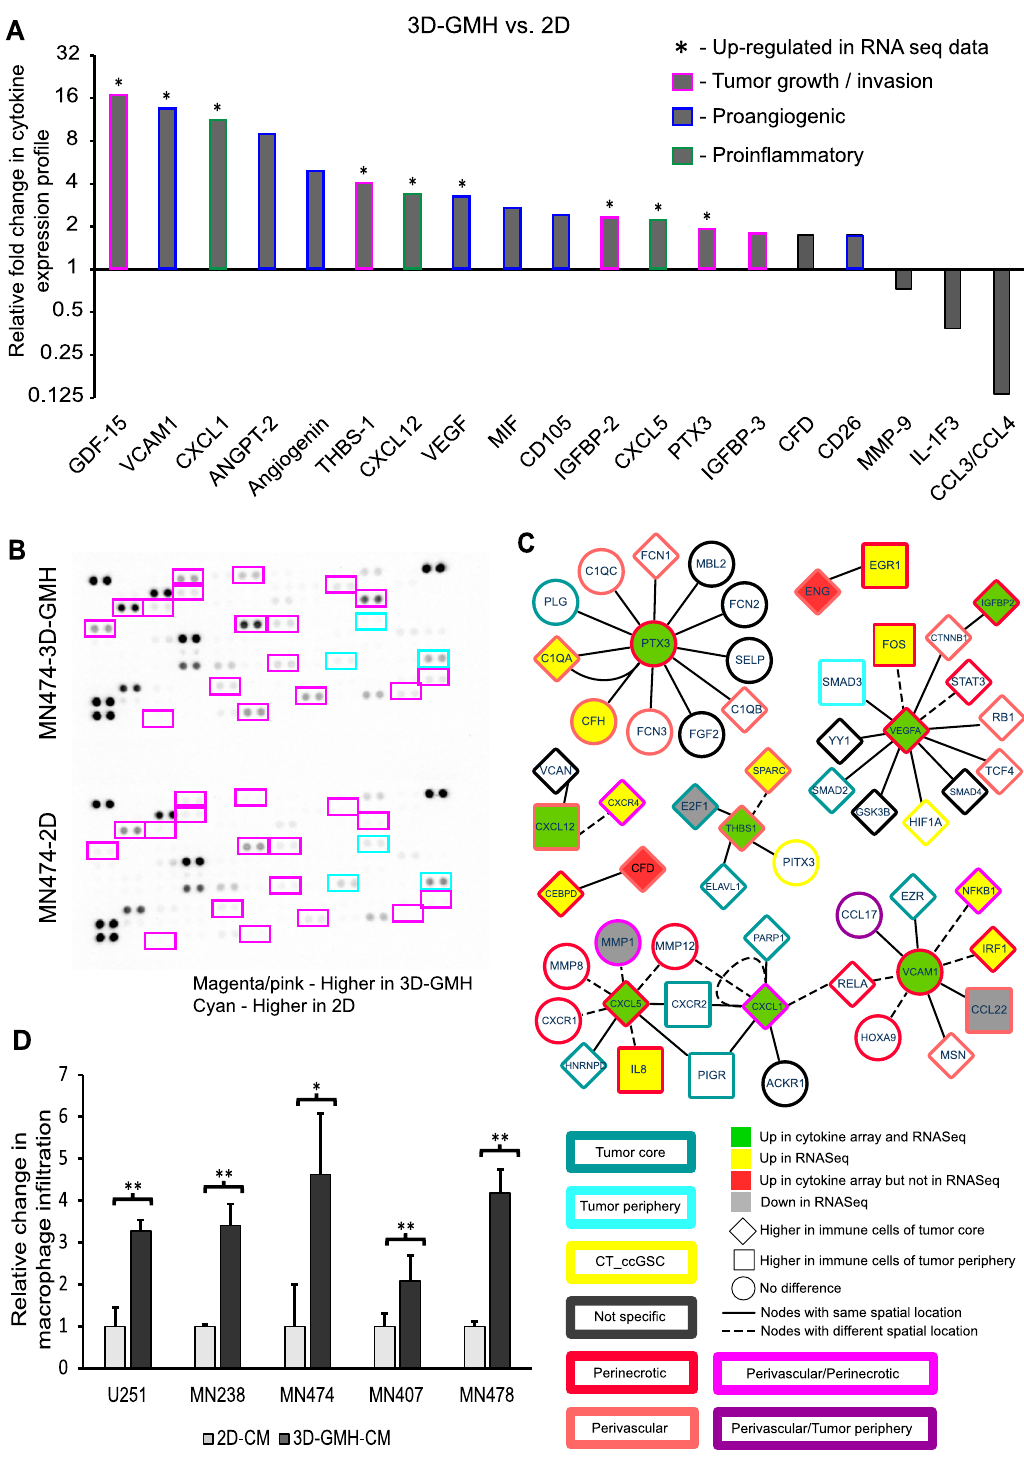
Figure 5. Glioma cells cultured on GelMA hydrogels enhance immune cell recruitment. ( A ) Fold change in cytokine RNA expression under 3D-GMH relative to 2D. Mean pixel density is normalized to 2D, + indicates that the respective gene is upregulated in RNA-seq data. ( B ) Cytokine levels in the CM of MN474 glioma cells cultured in 3D-GMH (Top) or 2D (Bottom). Magenta/pink bordered cytokine indicates enhanced secretion in cells cultured in 3D-GMH, and Cyan bordered cytokine indicates enhanced secretion in cells cultured on 2D. ( C ) The network derived from InnateDB 43 for cytokines that are enhanced in 3D-GMH vs. 2D CM generated using Cytoscape 50 . The fill color indicates the differential expression of the gene in the cytokine array as well as RNA-seq data (MN474 3D-GMH vs. MN474 2D). The shape indicates if the gene is differentially expressed in immune cells of the tumor core vs. tumor periphery 35 . The border color shows the spatial location where the gene is preferentially expressed. The error bar represents the standard deviation. *indicates p < 0.05, **indicates p < 0.01. ( D ) Boyden’s chamber invasion assay for U937-derived macrophages against CM of U251 cells and patient-derived glioma cells cultured in 2D and